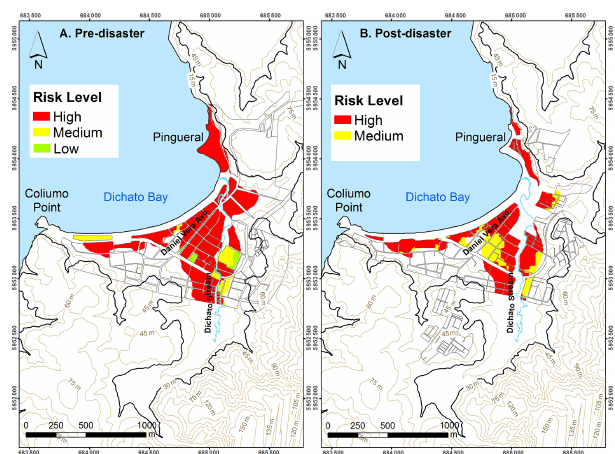
Figure 10. Tsunami risk areas for pre-event conditions.